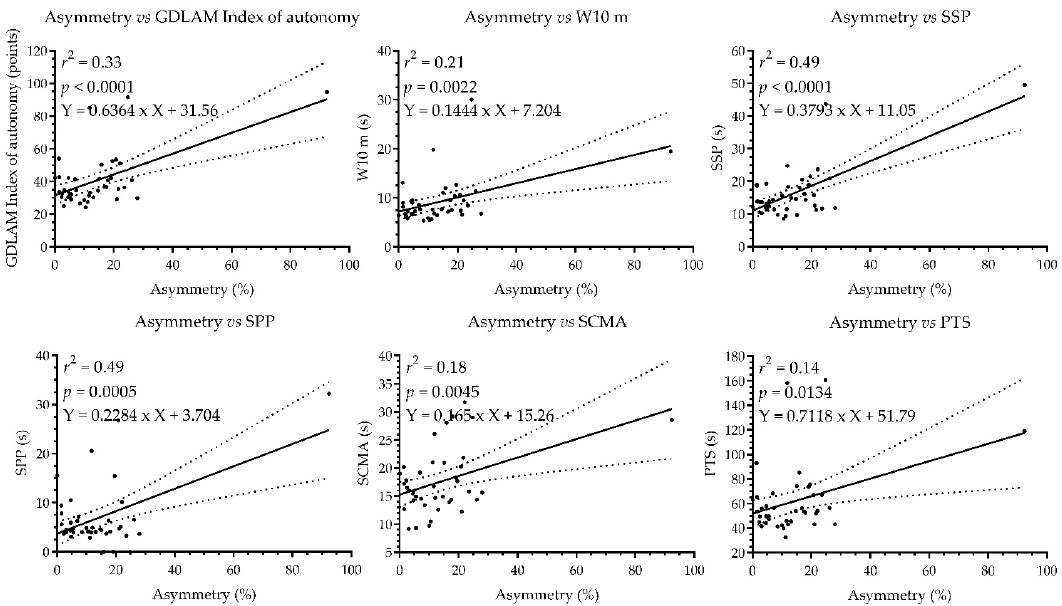
Table 2. Results of the GDLAM’S Protocol in older adults.